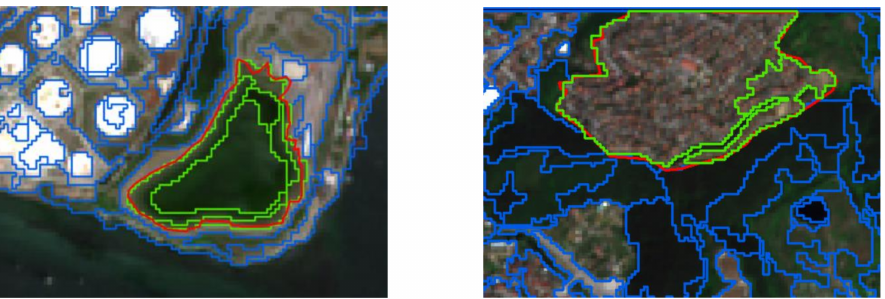
Figure 10. Samples of segmentation from Sentinel dataset. Red line refers to reference object; green line refers to MRS segments.